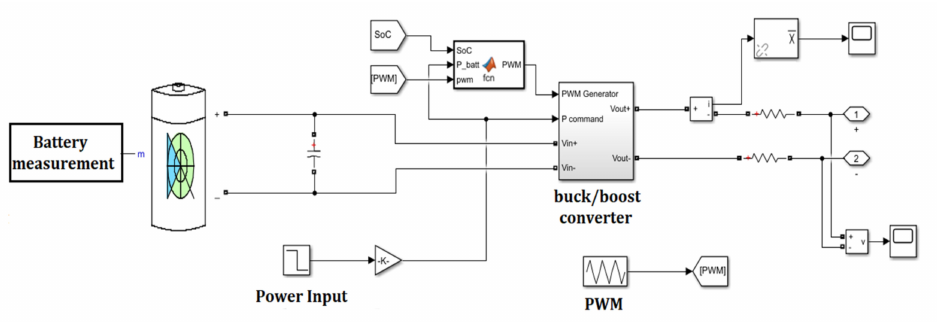
Figure 4. Li-Ion battery subsystem and its buck-boost converter, adapted with permission from [26], Elsevier,